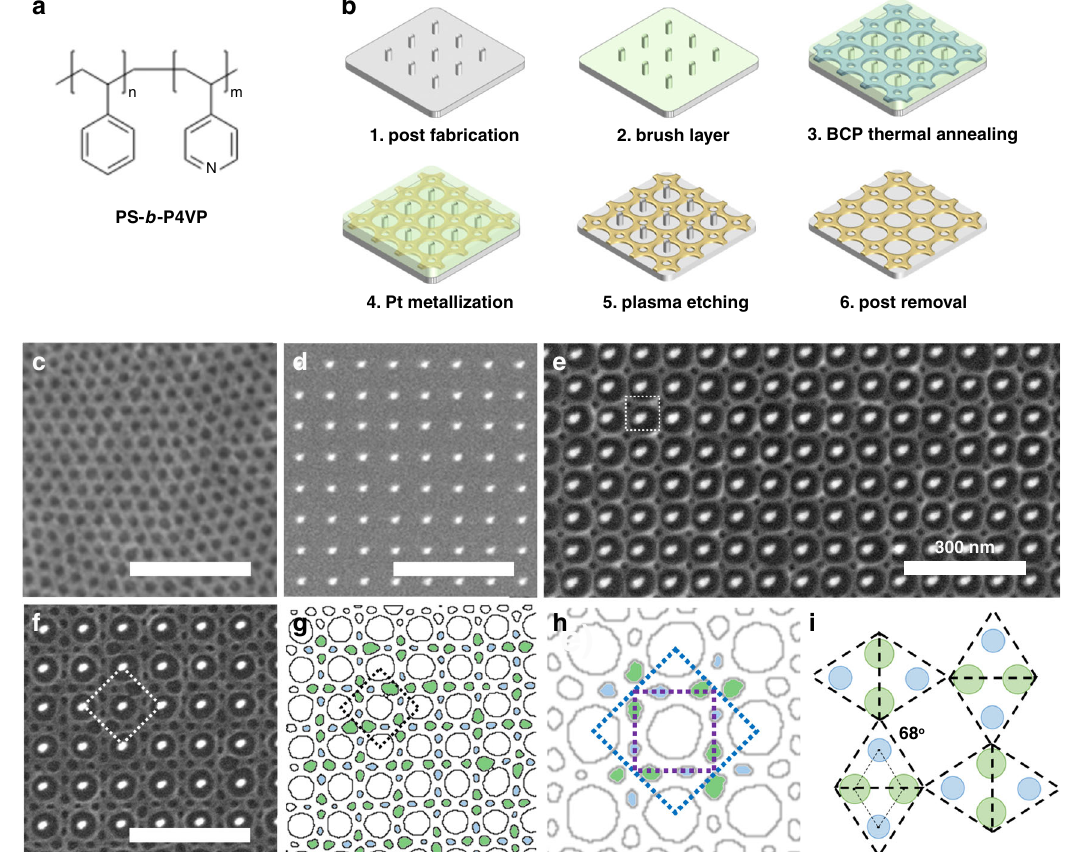
Fig. 1 BCP in square symmetric templates. a Chemical structure of PS- b -P4VP. b Fabrication procedure. c BCP assembly without post arrays. d Square symmetric post arrays. e BCP in post arrays ( L p = 80 nm.) f BCP in post arrays ( L p = 100 nm), exhibiting broken symmetry and supperlattice structure. g PS domain contours in which the four domains between the posts are highlighted. Green domains are larger and align along the short axis of rhombus, blue are smaller and along the long axis of rhombus. Dashed line indicates the unit cell. h Purple dashed line indicates the unit cell for templates and blue dashed line (the same area in g ) is the unit cell for the BCP, which has two-times greater area; i schematics of the PS domains in one unit cell; the dashed parallelogram boxes indicates the relationship between the as-obtained BCP geometry and the 3 2 434 Archimedean tessellations (note that the triangles are not equilateral). The scale bars in c – f are 500 The free-energy plots are shown in Fig. 2d and Supplementary Fig. 4d. When D x = D y , the four PS domains adopt a square arrangement (Fig. 2c and Supplementary Fig. 4a). The interfacial energy, i.e., enthalpic contribution, continuously decreases when the polymer domains are brought closer (Supplementary Fig. 4c) and has a minimum at D x = D y = 0.40 L p . The stretching energy, i.e., the entropic contribution, demonstrates a minimum at D x = D y = 0.56 L p (Supplementary Fig. 4b), with deviation from this con fi guration resulting in more tension/compression of the polymer chains. The combined free energy of the square shape domains is lowest at D x = D y = 0.54 L p , translating to an equilibrium edge length of 0.38 L p . When D x ≠ D y , i.e., the four PS domains adopt the rhombus arrangement. The minimum free energy is located at D x = 0.68 L p and D y = 0.46 L p , corresponding to a rhombus with a side length of 0.41 L p and acute angle of 68°, in excellent agreement with the experimental fi ndings. This structure is 0.034 nk b T lower in stretching energy and 0.035 nk b T lower in interfacial energy, indicating that the broken symmetry is driven by both entropy and enthalpy.